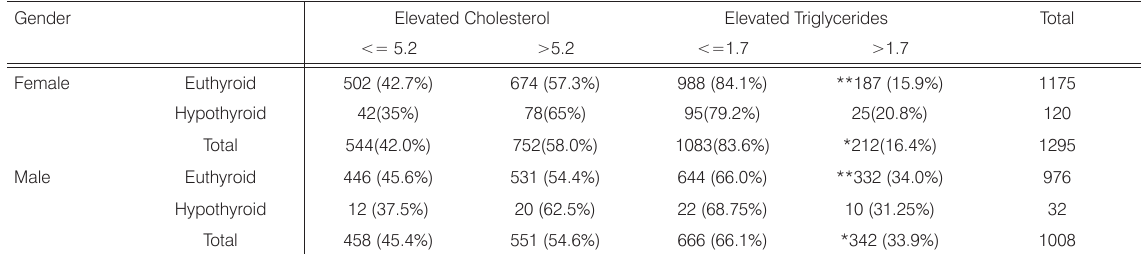
Table 3. Prevalence of hypercholesterolemia and hypertrigyceridemia in the studied population by gender and thyroid